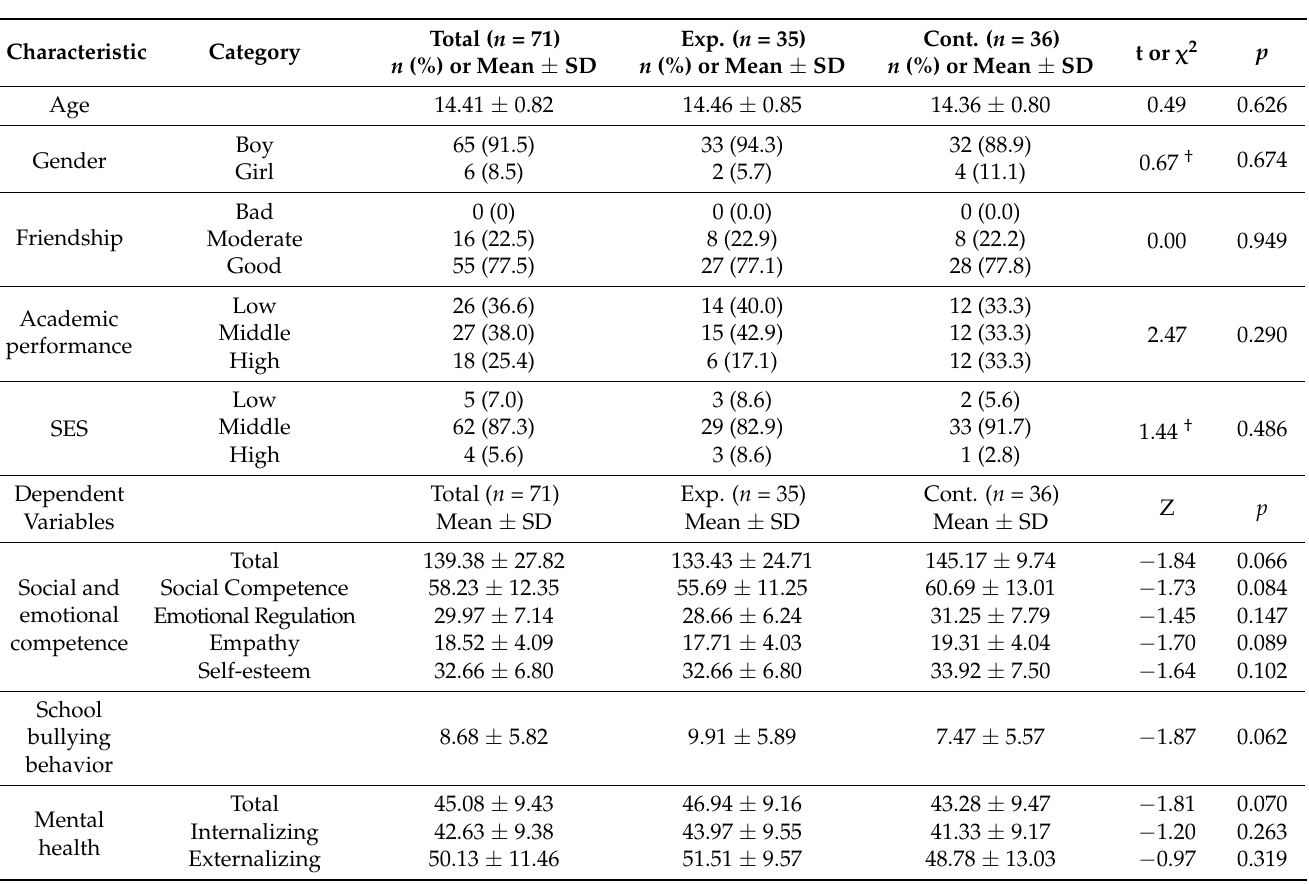
Table 2. Homogeneity verification for participants’ general characteristics and dependent variables ( n =